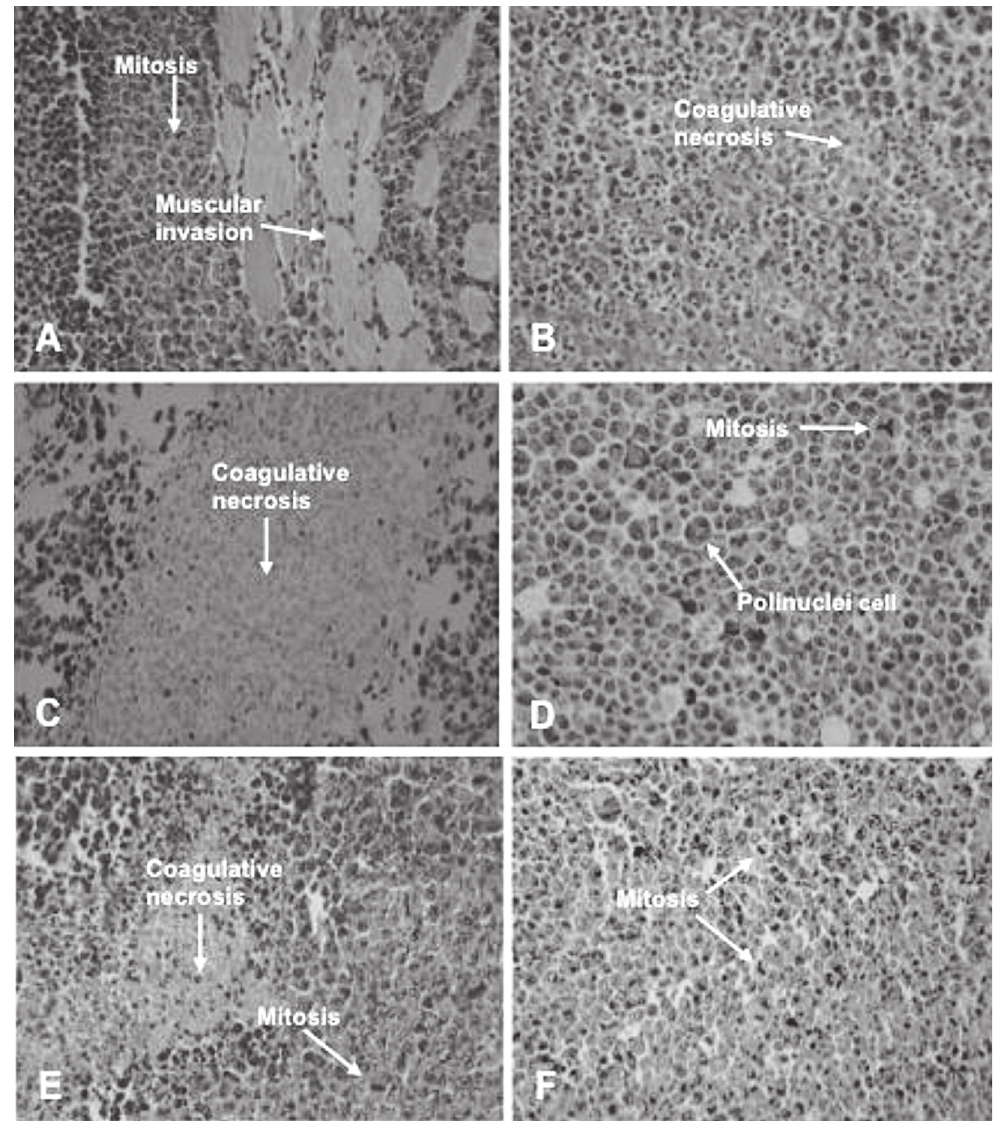
Figure 3 - Histology of Sarcoma 180 tumors removed from untreated or N-phthaloyl amino acid derivatives-treated mice with 50 mg/kg/day after 7 days. A – Control (4 % DMSO); B – Thalidomide; C – 5-Fluorouracil (25 mg/kg/ day); D – Compound 3c; E – Compound 4; F – Compound 5. Hematoxylin-eosin staining. Magnification, x